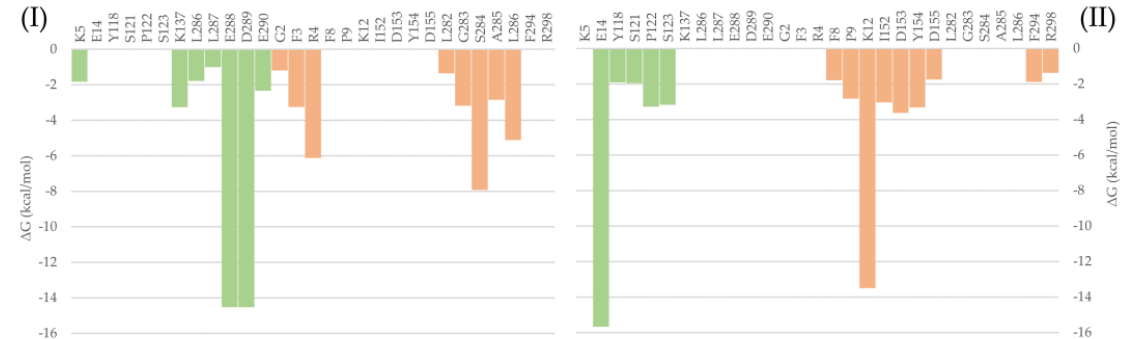
Figure 4. Free binding energy per residue decomposition for the two allosteric binding sites of Hyperoside in complex with the SARS-CoV-2 M pro main protease dimer. On the left ( I ), the best binding site identified, with a free binding energy of −60.1 kcal/mol. On the right ( II ), the second binding site identified, with a free binding energy of −53.3 kcal/mol. The different monomers of the dimer are depicted in light green (Chain A) and light orange (Chain B).